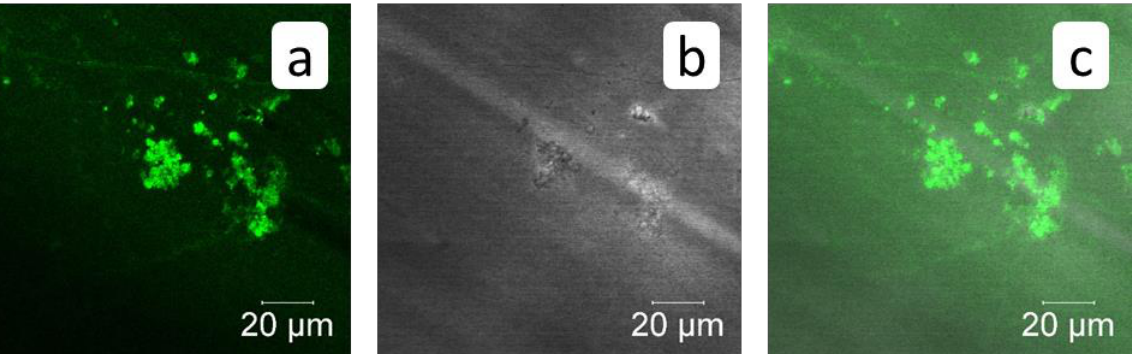
Figure 11. Fluorescent images of membrane surface after RO treatment in the presence of PAA-F1: a — PAA-F1 fluorescence - green pseudo-color; b — transmitted light image (grey color); c — imposition of a and b channels.